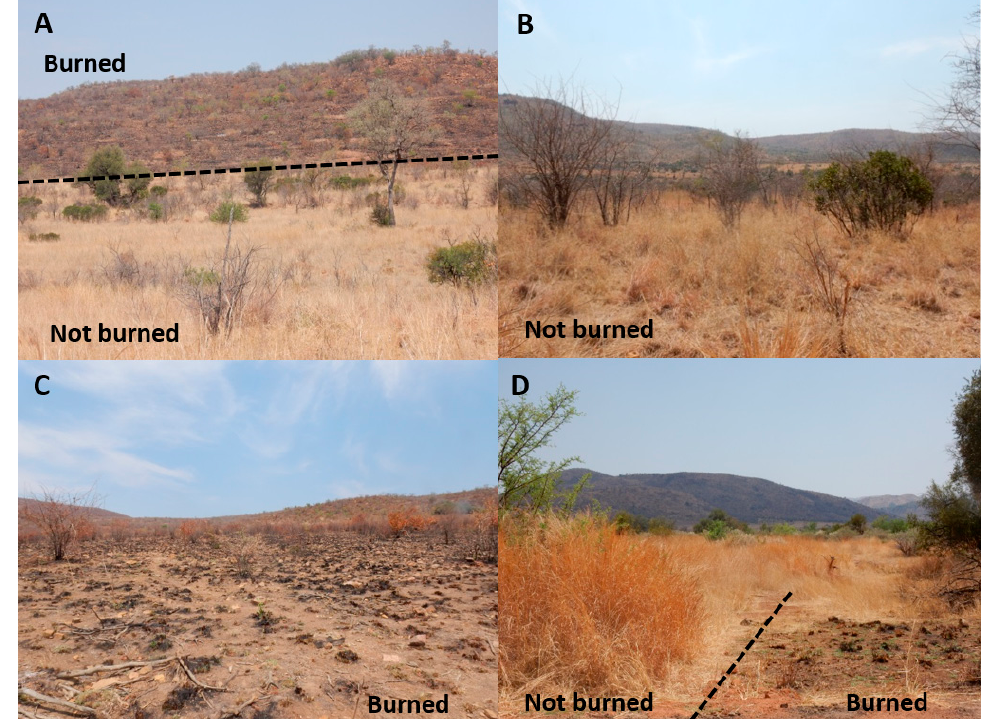
Figure 2. Example of southern African savannah fire effects in the dry season. ( A ) Burned area in the background versus unburned area in the foreground, ( B ) unburned area close-up, ( C ) burned area close-up, ( D ) contrast between a burned patch to the right and non-burned grass patch to the left (photos Renaud Mathieu). Note that surface fires remove the grass layer.